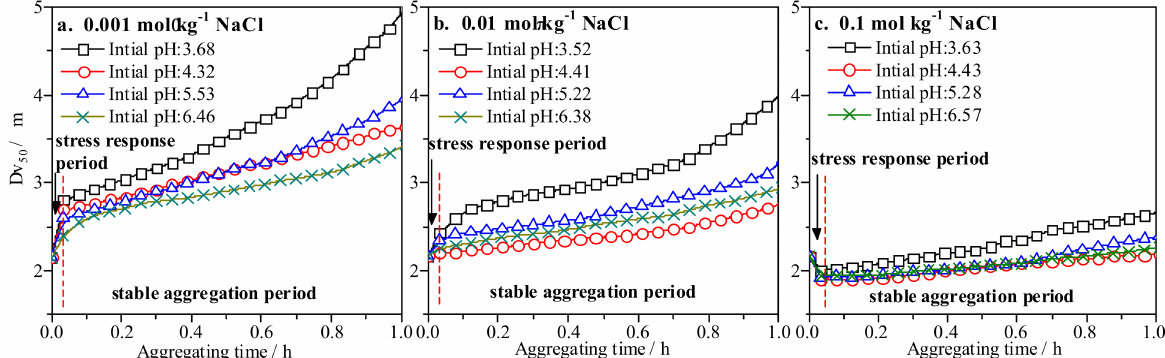
Figure 4. Impact of pH and salinity perturbation on Dv 50 of the IREO colony. ( a ) 0.001 mol · kg − 1 NaCl; ( b ) 0.01 mol · kg − 1 NaCl; ( c ) 0.1 mol · kg − 1 NaCl.